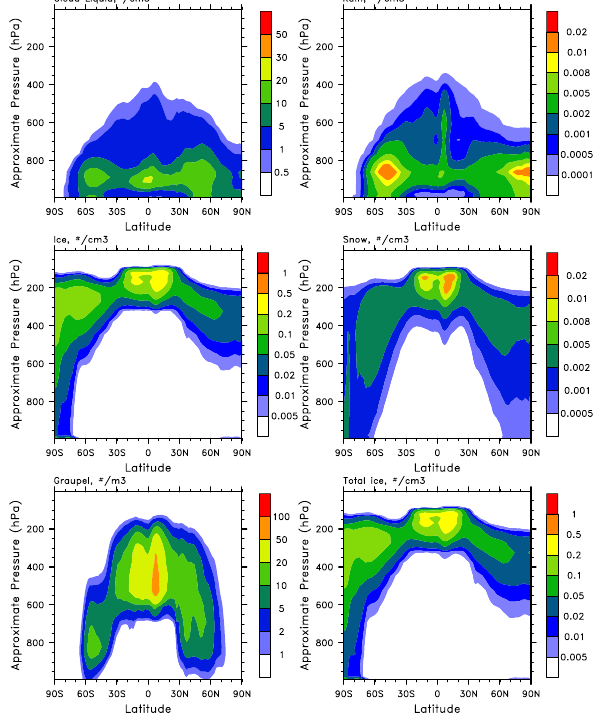
Figure 02 Fig. 2. The same as Fig. 1, but for hydrometeor number concentra- tions (units: m − 3 for grauple, and cm − 3 for other hydrometeors).